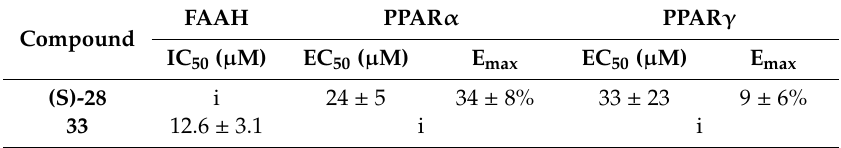
Table 4. Biological activities of the only active derivatives of rosmarinic acid. i: inactive.